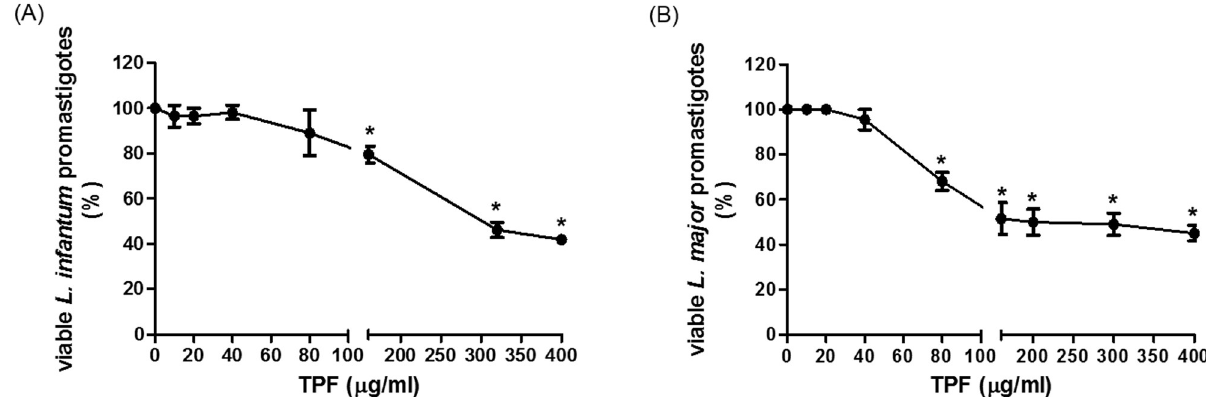
Fig 1. Effect of TPF on the viability of L . infantum and L . major promastigotes.